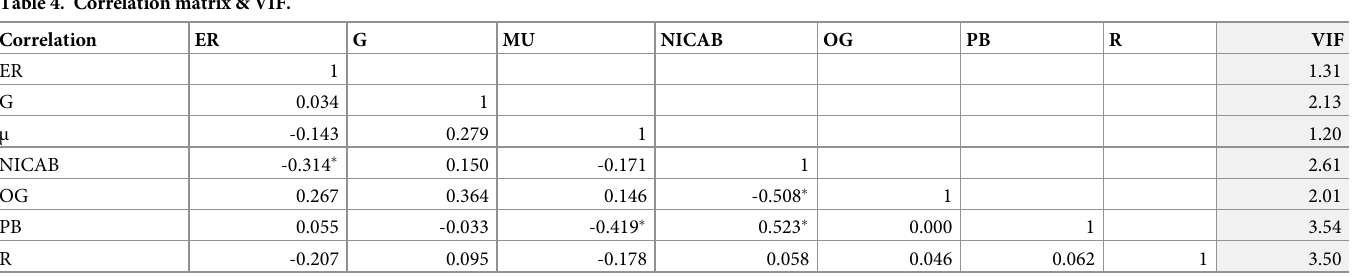
Table 4. Correlation matrix & VIF. Correlation